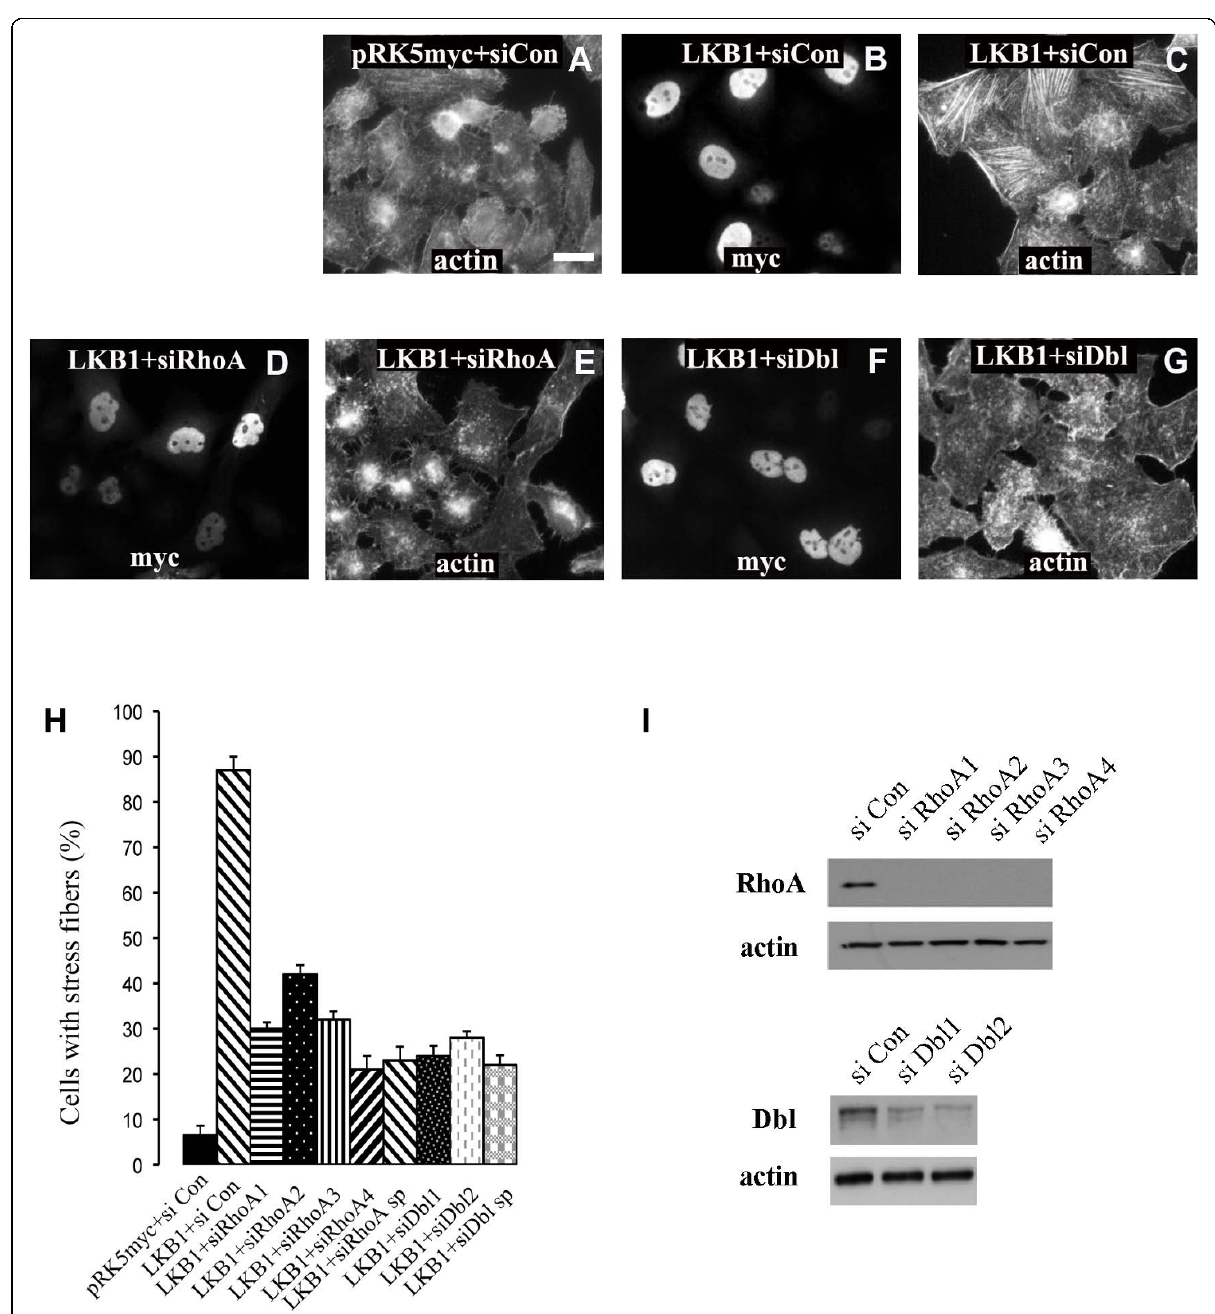
Figure 3 Stress fiber formation is mediated by RhoA and Dbl . HeLa-S3 cells were transfected with siRNAs and then re-transfected 2 days later with myc-tagged wild type LKB1. A . HeLa-S3 cells transfected with control siRNA followed 2 days later by empty vector. B, C . Cells transfected with control siRNA followed 2 days later by a myc-tagged LKB1 construct. D, E . Cells transfected with RhoA siRNA SMARTpool followed 2 days later by a myc-tagged LKB1 construct. F, G . Cells transfected with Dbl SMARTpool siRNA followed 2 days later by a myc-tagged LKB1 construct. H . Quantification of stress fiber formation. Four individual siRNAs (1-4) and the SMARTpool (sp) are shown for RhoA and two individual siRNAs (1,2) and SMARTpool (sp) are shown for Dbl. I . Western blot showing effectiveness of individual siRNAs in depleting endogenous RhoA and Dbl proteins. Cell lysates were harvested 3 days after siRNA transfection. Scale bar = 20 μ